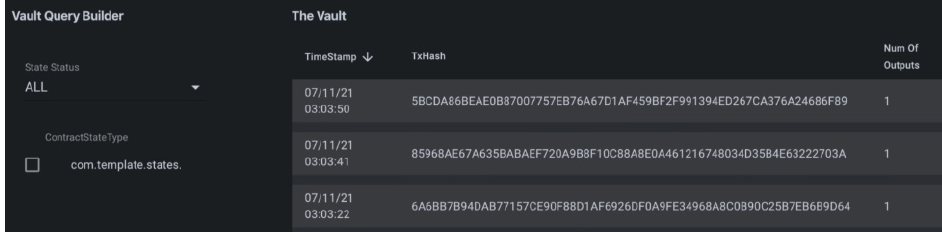
Figure 5. Vault query